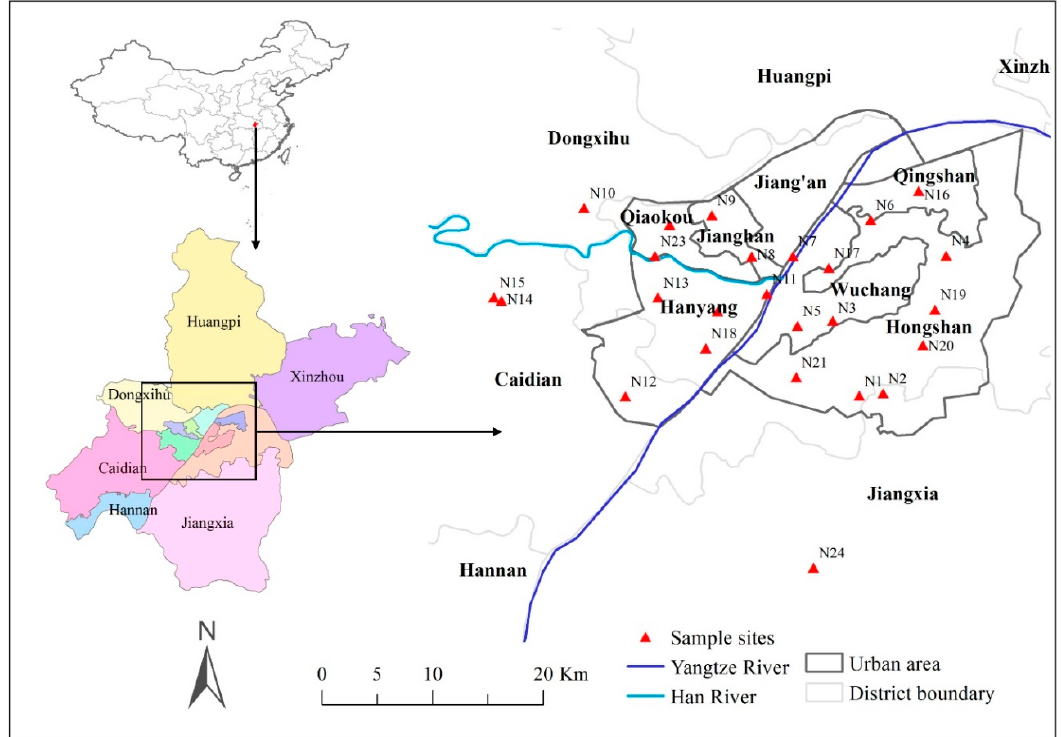
Figure 1. Map of the study area with sampling sites in the urban areas of Wuhan. N1–N25 are the sample sites, and detailed information is presented in Table S1.